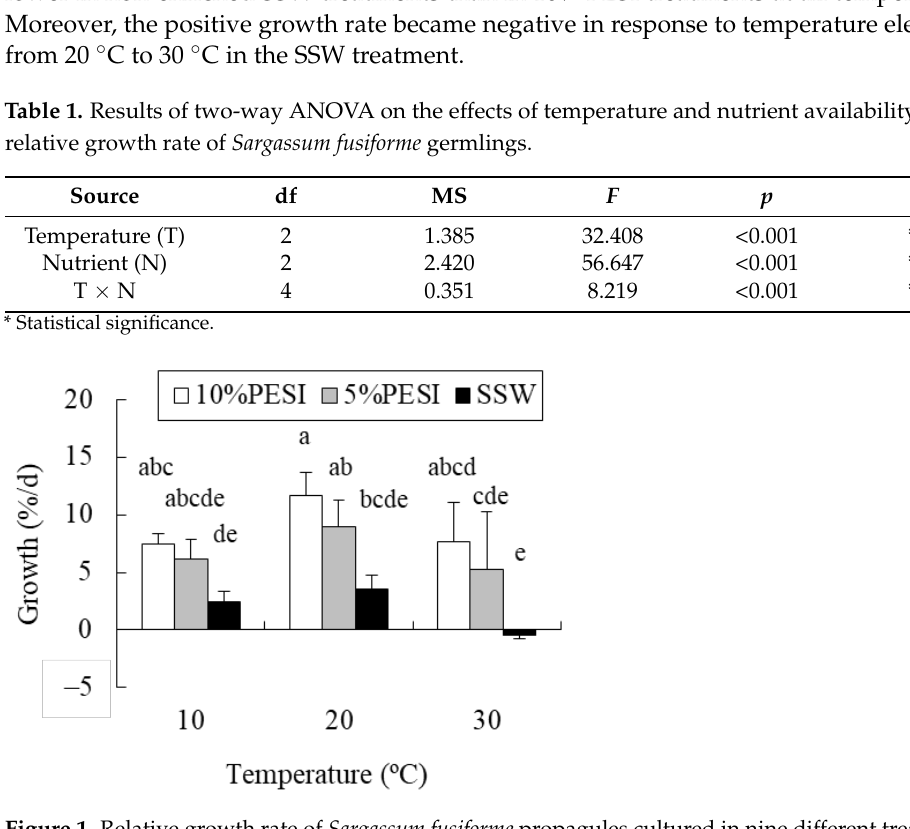
Figure 1. Relative growth rate of Sargassum fusiforme propagules cultured in nine different treatments (Mean + SD, n = 6). Different small letters indicate statistical significance among different treatments ( p < 0.05).